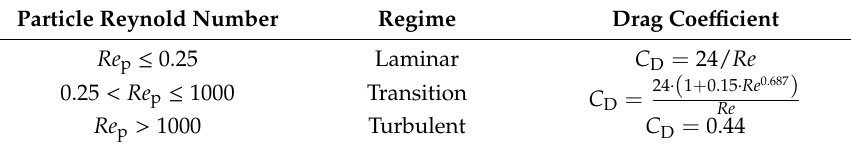
Table 1. Calculation of the drag coe ffi cient depending on the particle Reynold